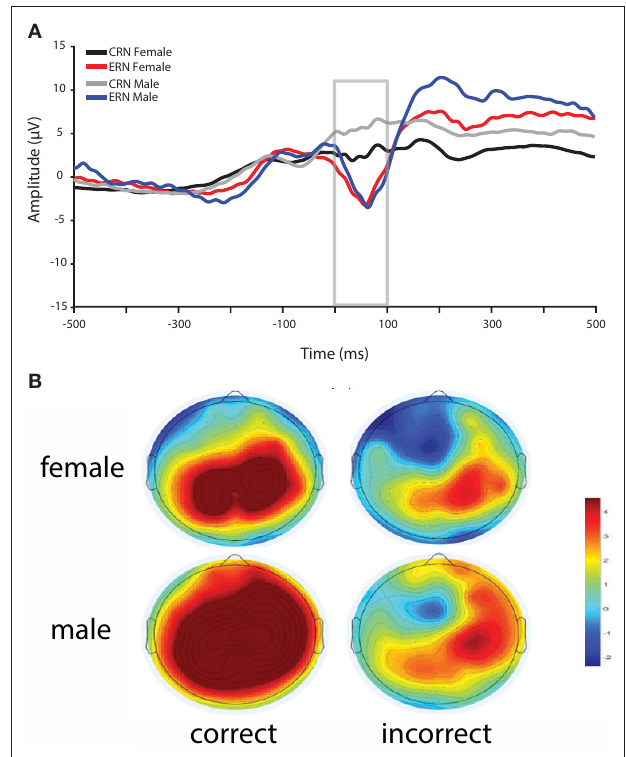
FIGURE 2 | (A) ERN and CRN waveforms for incorrect and correct responses for female and male participants. ERN amplitudes did not differ between female and male participants, whereas CRN amplitudes and 1 ERN (incorrect–correct) amplitudes were greater in male participants. (B) Scalp topography for correct and incorrect response between 0 and 100ms post-response for females (top) and males